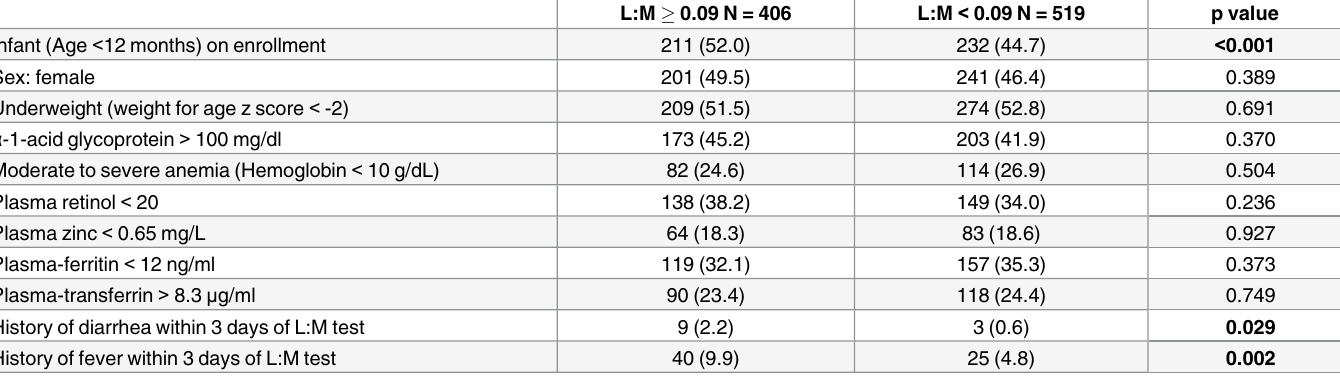
Table 3. Age, sex, nutritional status, biochemical characteristics, and morbidities by impaired intestinal mucosal -integrity and -permeability (L: M (cid:21) 0.09), bivariate analysis.